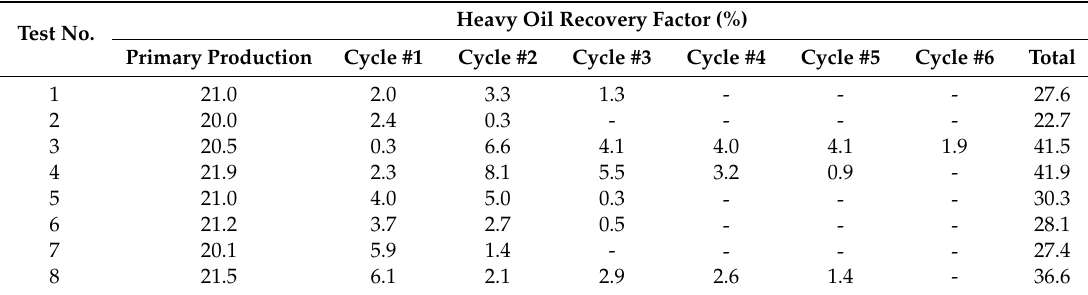
Table 3. Heavy oil recovery factors during the primary production and each cycle of the CSI tests